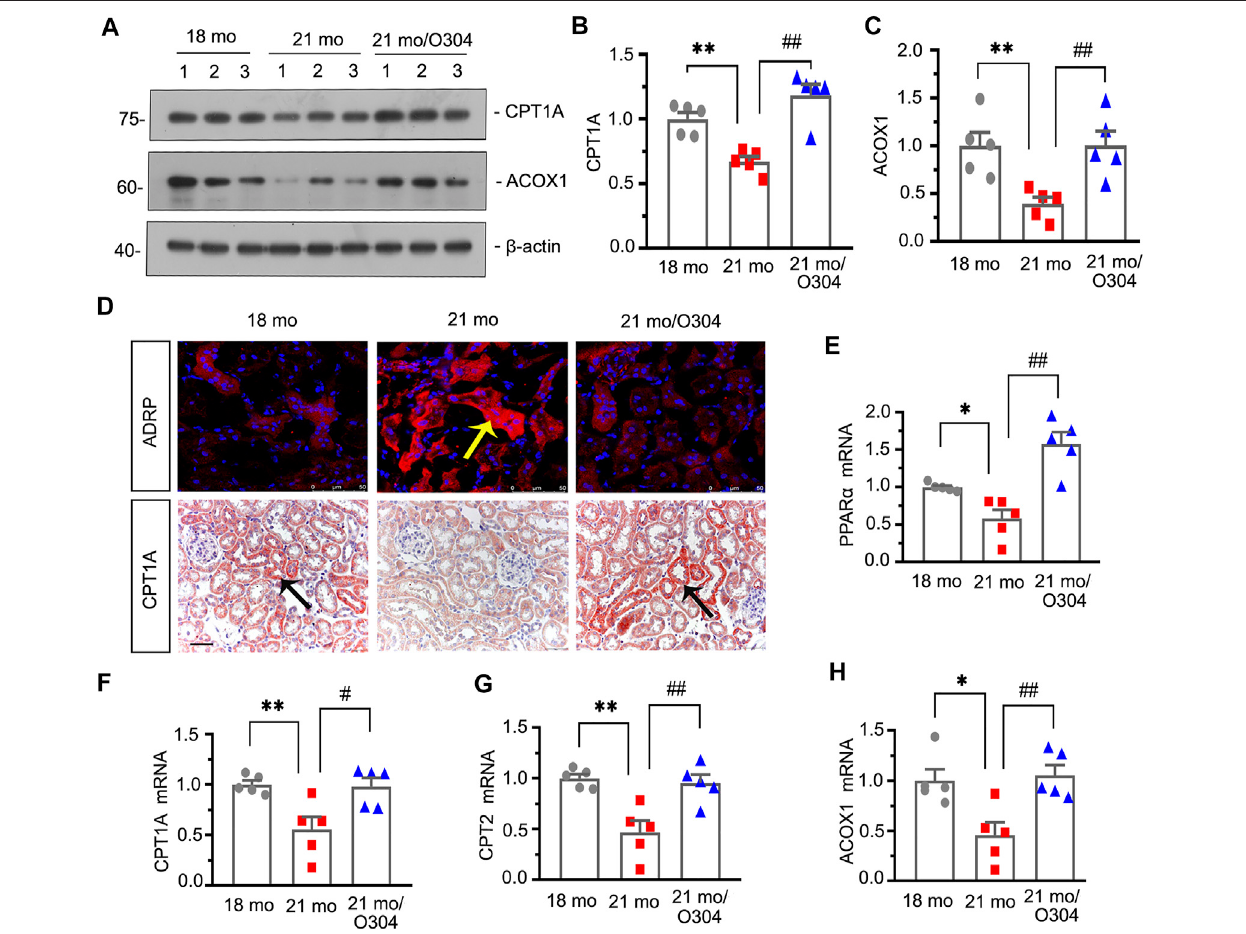
FIGURE 5 | O304 could promote fatty acid metabolism in naturally aging mice. (A – C) Representative western blot and quantitative data showing renal expression of CTP1A and ACOX1 in different groups. Numbers (1 – 3) indicate each individual animal in each given group. ** p < 0.01 versus 18-month-old mice group. ## p < 0.01 versus 21-month-old mice group alone ( n = 5). (D) Representative micrographs showing ADRP (top) and CPT1A (bottom) expression in kidneys in different groups. Cryosections were subjected to fl uorescence staining for ADRP. Paraf fi n-embedded kidney sections were immunostained with an antibody against CPT1A. Arrows indicate positive staining. scale bar, 50 μ m. (E – H) Graphical representations show the relative abundance of PPAR α , CPT1A, CPT2 and ACOX1 mRNA in different groups. * p < 0.05, ** p < 0.01 versus 18-month-old mice group. # p < 0.05, ## p < 0.01versus 21-month-old mice group alone ( n = 5).